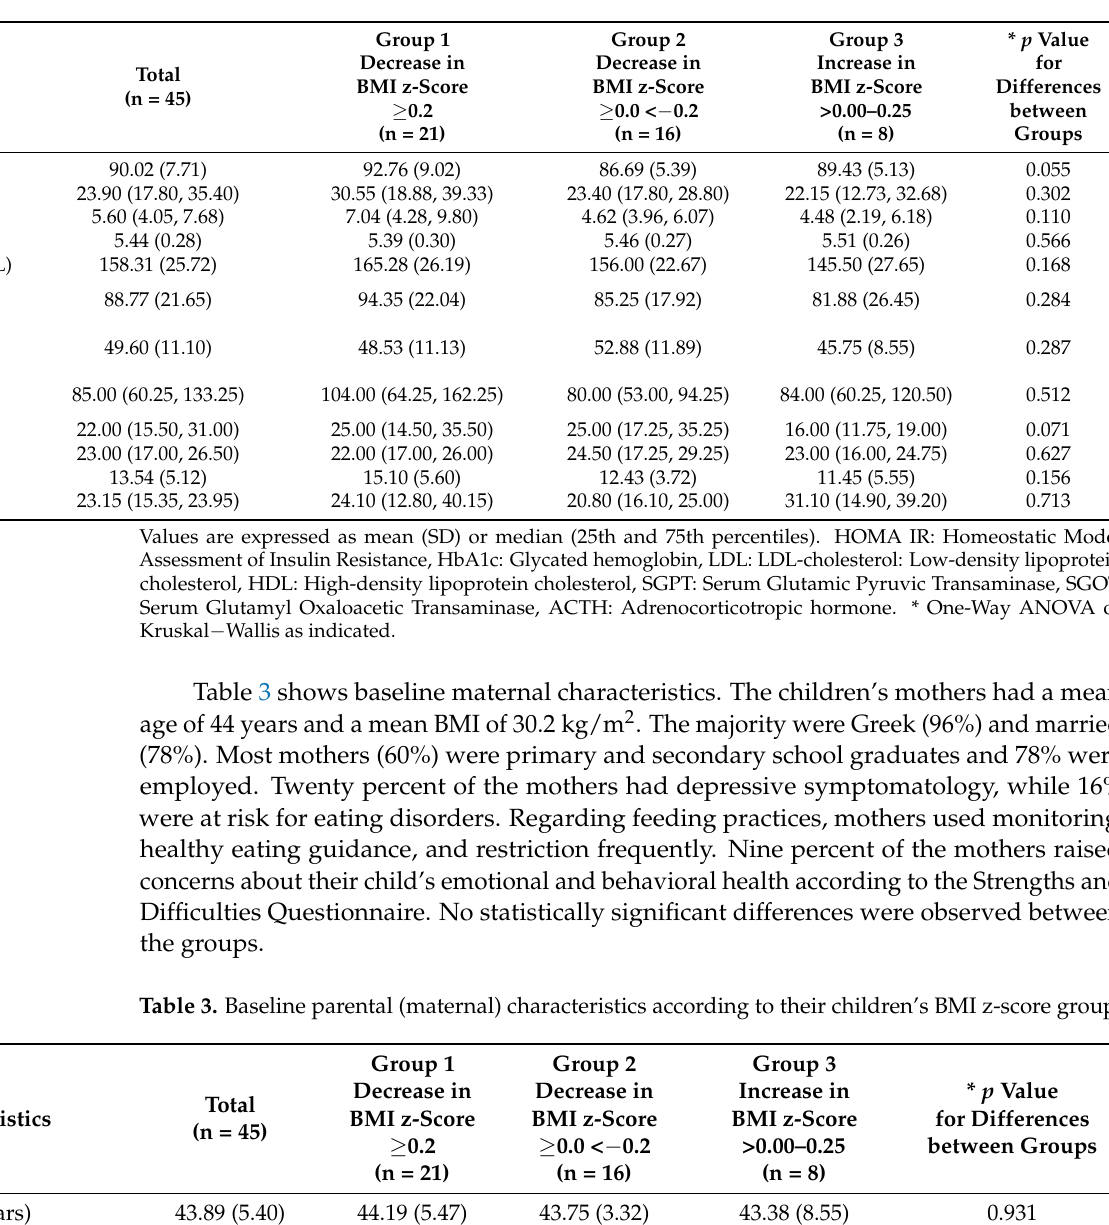
Table 2. Baseline metabolic characteristics of children according to BMI z-score group.